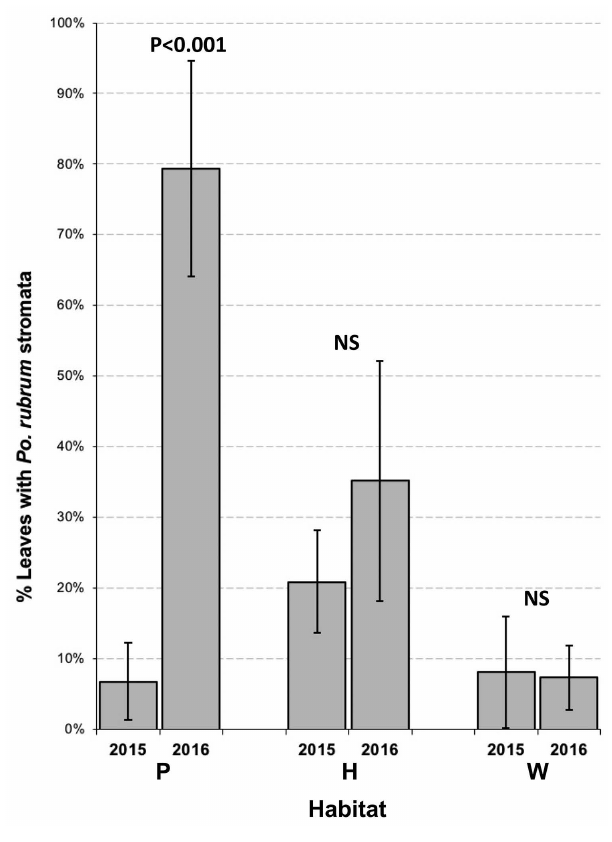
Figure 2 – Percentage of Prunus spinosa leaves at the Carran fieldsite infected with Polystigma rubrum in open limestone pavement (P), hedgerow (H) and woodland (W). Abundance of stromata was higher in 2016 than 2015 but only in pavement and hedgerow habitats (ANOVA). Combining data over two years, stromatal abundance was greater in hedgerows and pavement than woodlands (Kruskal-Wallis P < 0.001; n = 6–12 replicates); NS indicates not significant.